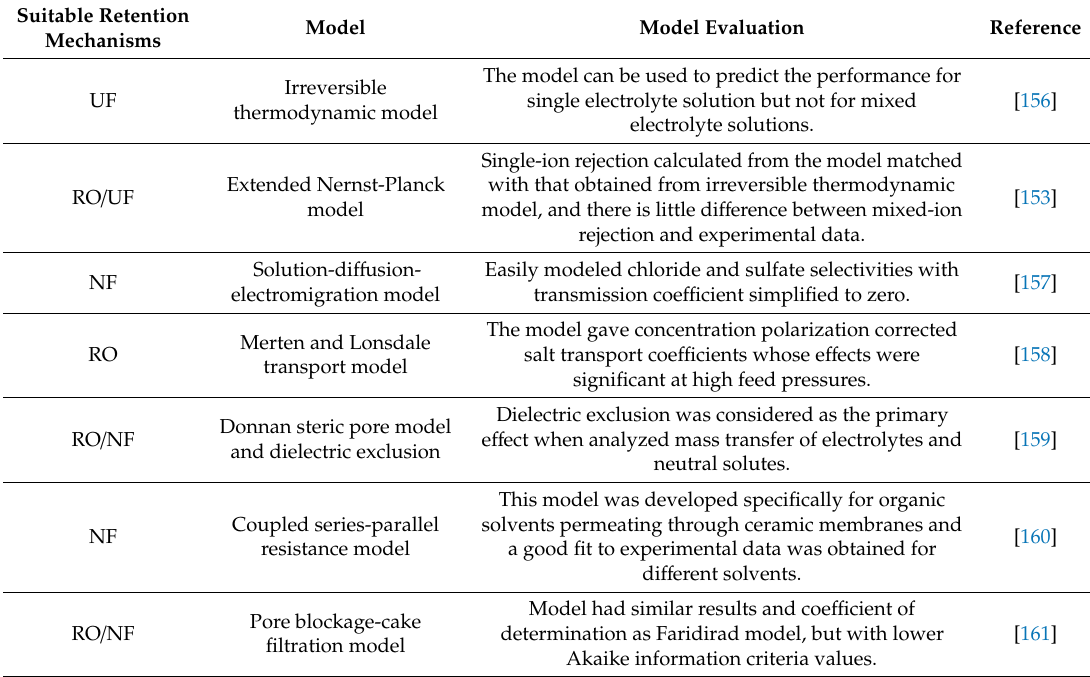
Table 5. Recent models for transport of aqueous electrolytes through charged membranes. Suitable Retention Model Model Evaluation Mechanisms